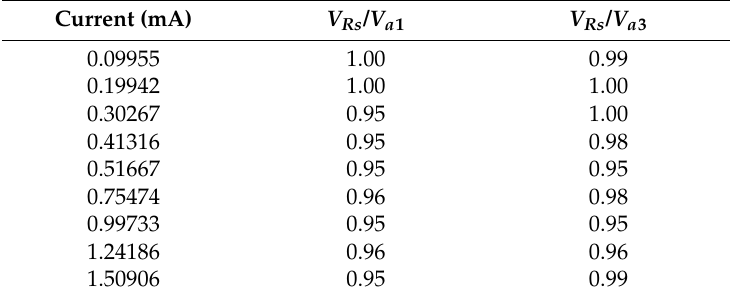
Table 2. Relationship between access voltage and current amplitude of excitation signal for electrode B.